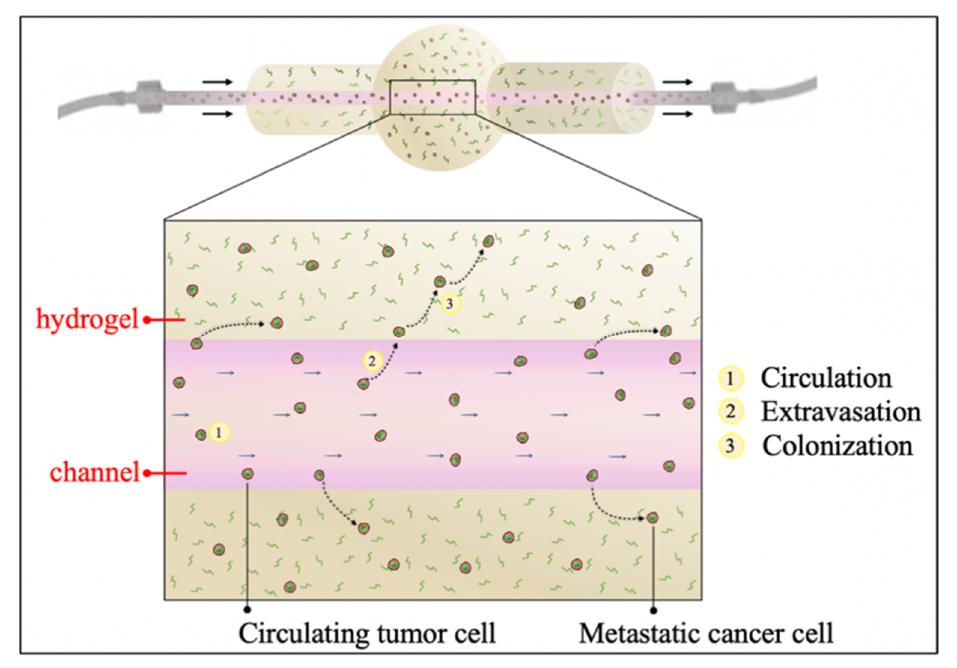
Figure 1. Schematic representation of the main steps of the metastatic cascade.